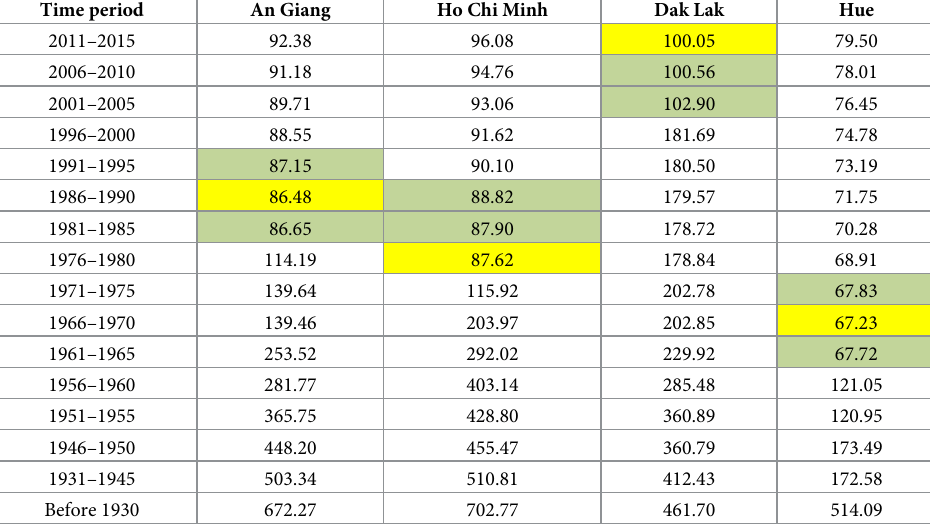
Table 1. Table of DIC values calculated from 16 models in 4 locations. Each model is defined to have different times of transmission ending, as shown in the first column of the table. Yellow coloured cells are the best models in each location. Green colored cells are the models which have DIC value rank 2 nd and 3 rd from the bottom up, hence the 2 nd and 3 rd best models. The FOI estimates from the 2 nd and 3 rd models are shown in Figure A in S2 Text. Time period An Giang